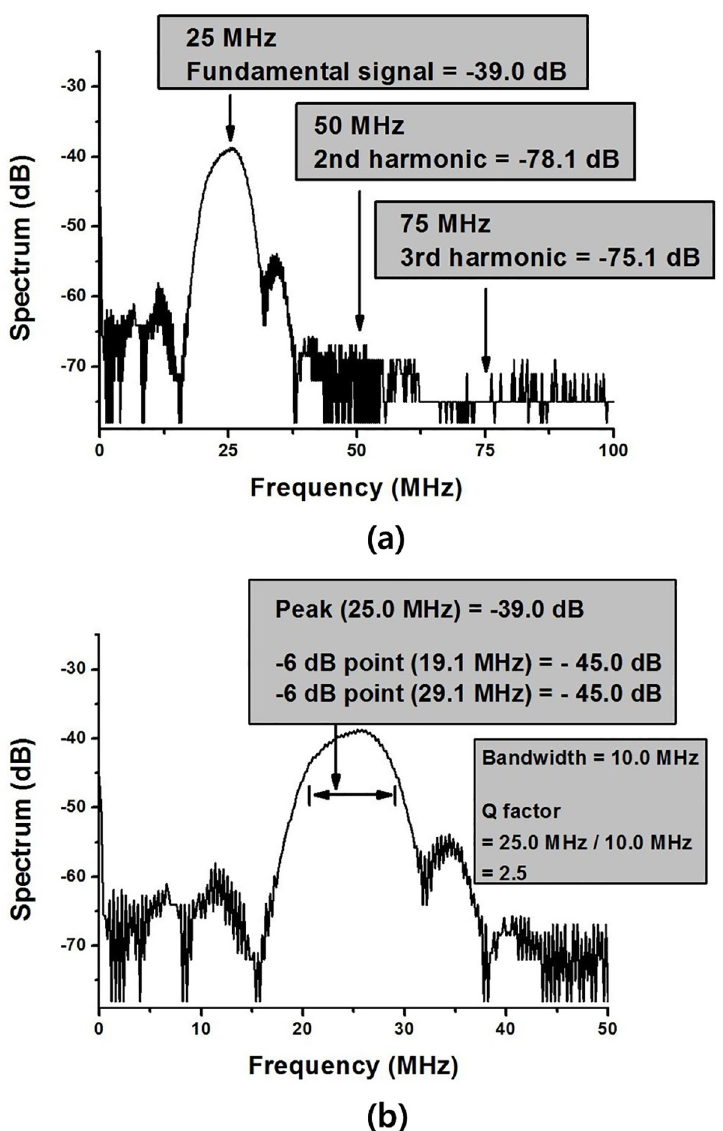
Fig 16. FFT spectrum data transmitted and received by a high-efficiency and high-voltage class F amplifier and 25-MHz transducers. (a) FFT spectrum data for fundamental signal, second harmonic and third harmonic (b) FFT spectrum data enlarged to show bandwidth.